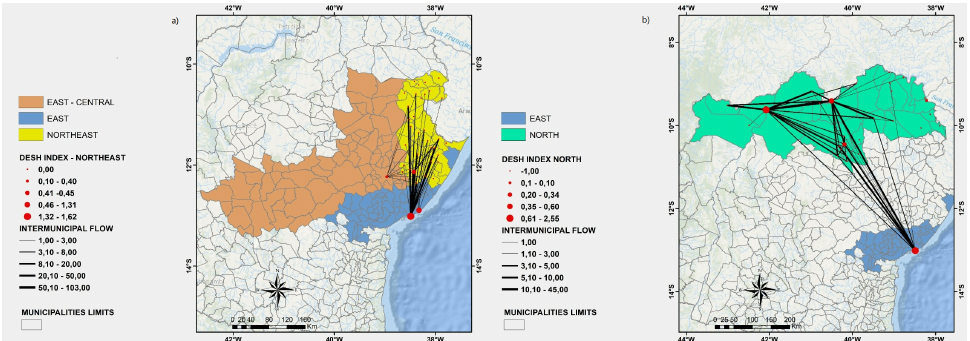
Figure 5. ( a ) A visualization of the East-Central, East, Northeast regions. ( b ) A visualization of the East and North regions. Source: Author.